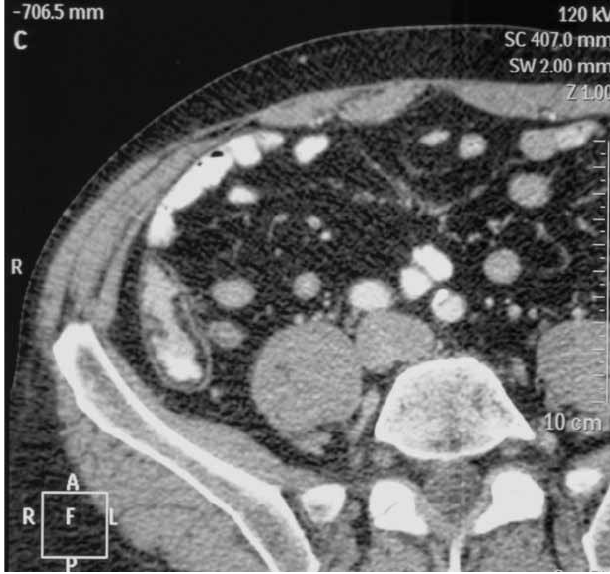
Fig. 1c. Axial post contrast CT abdomen of the same patient with oral contrast demonstrates a low-attenuation fat layer in the wall of the caecum